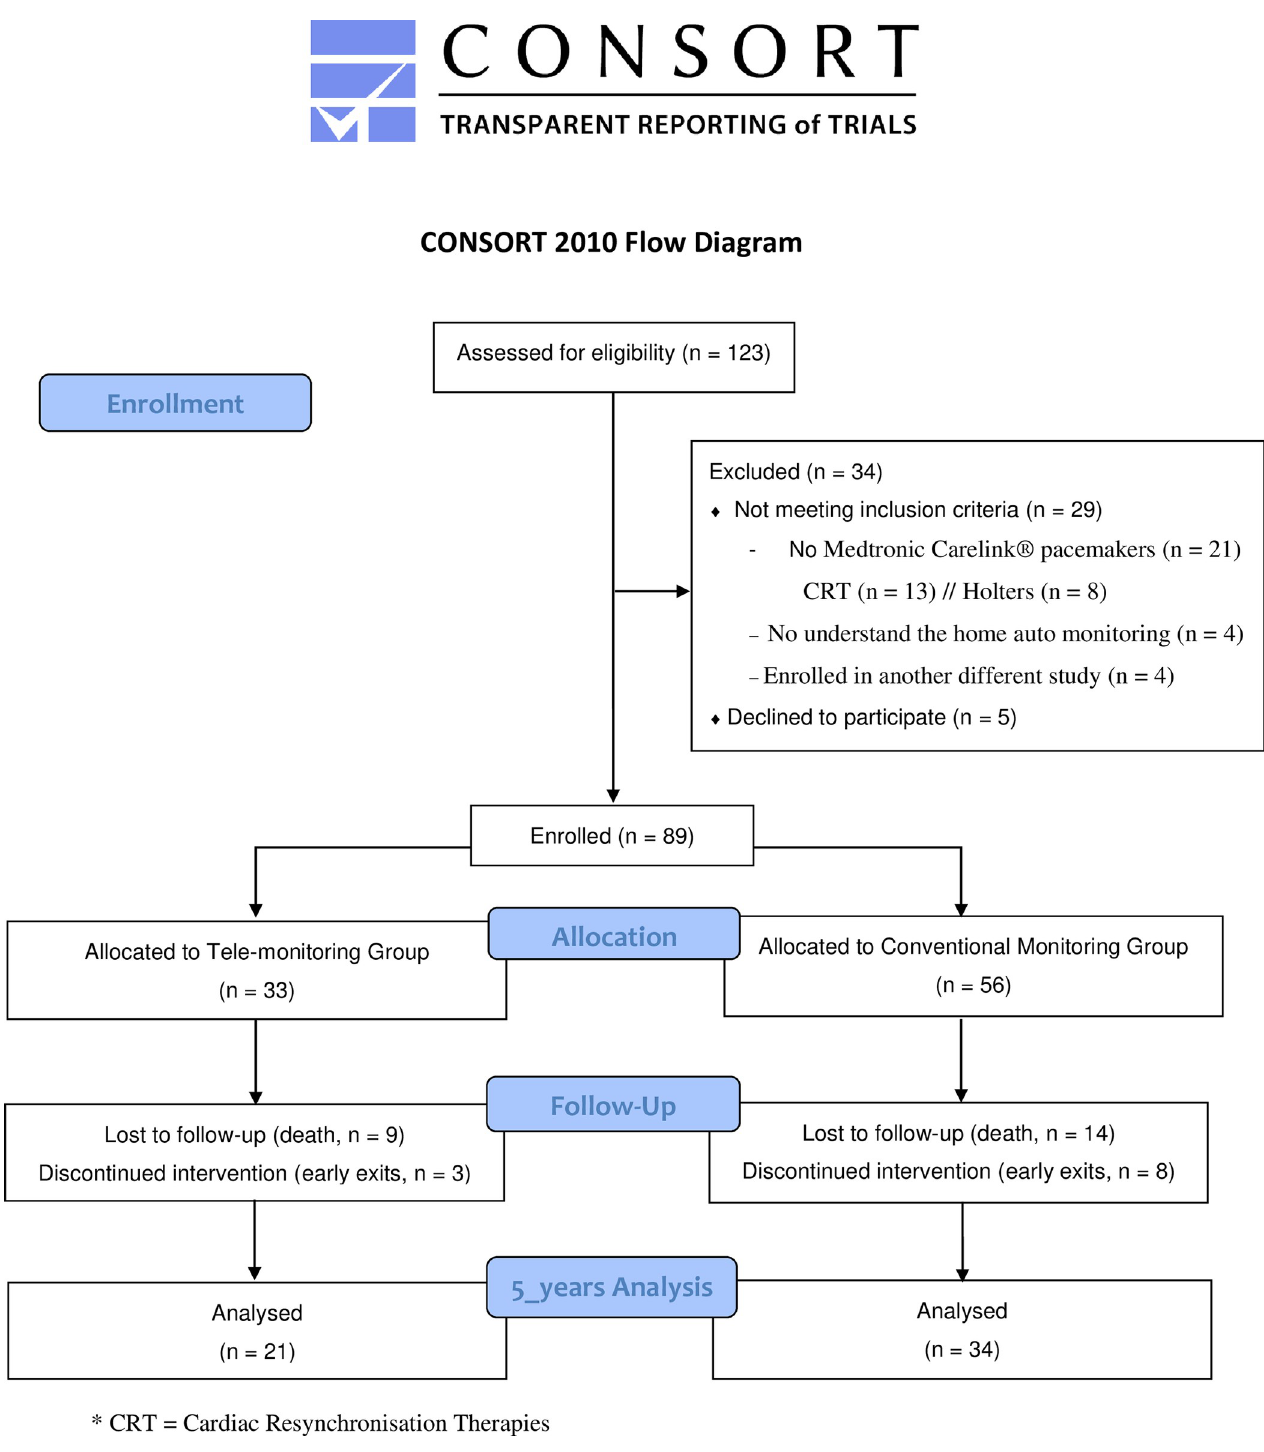
Fig 1. CONSORT flow diagram.